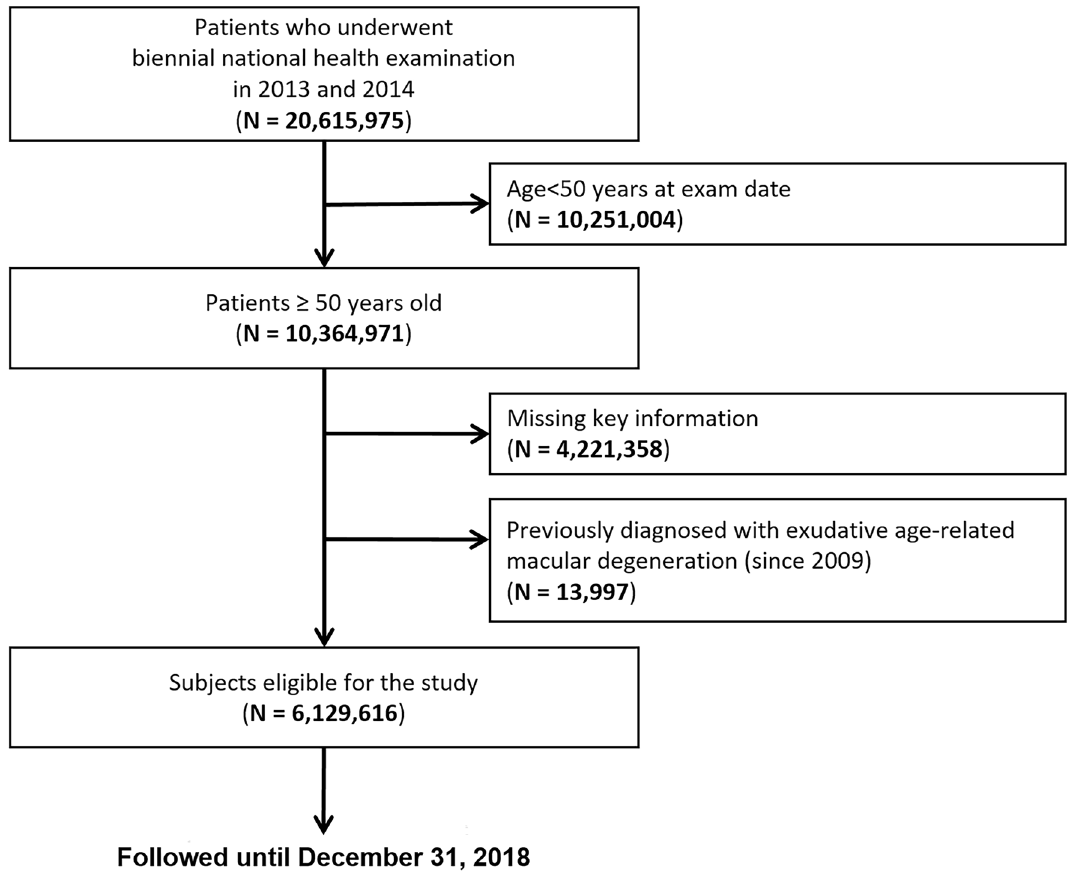
Figure 1. Flow chart of the cohort study